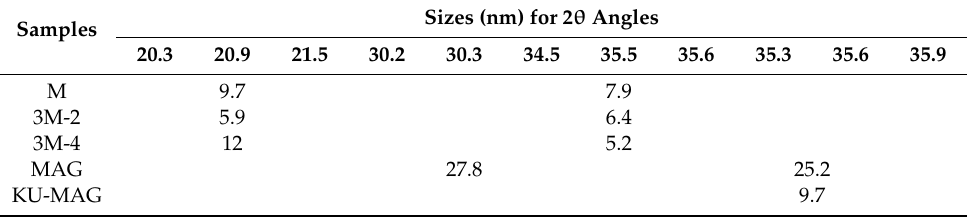
Table 1. Particle sizes of iron oxides in the investigated sorption materials.